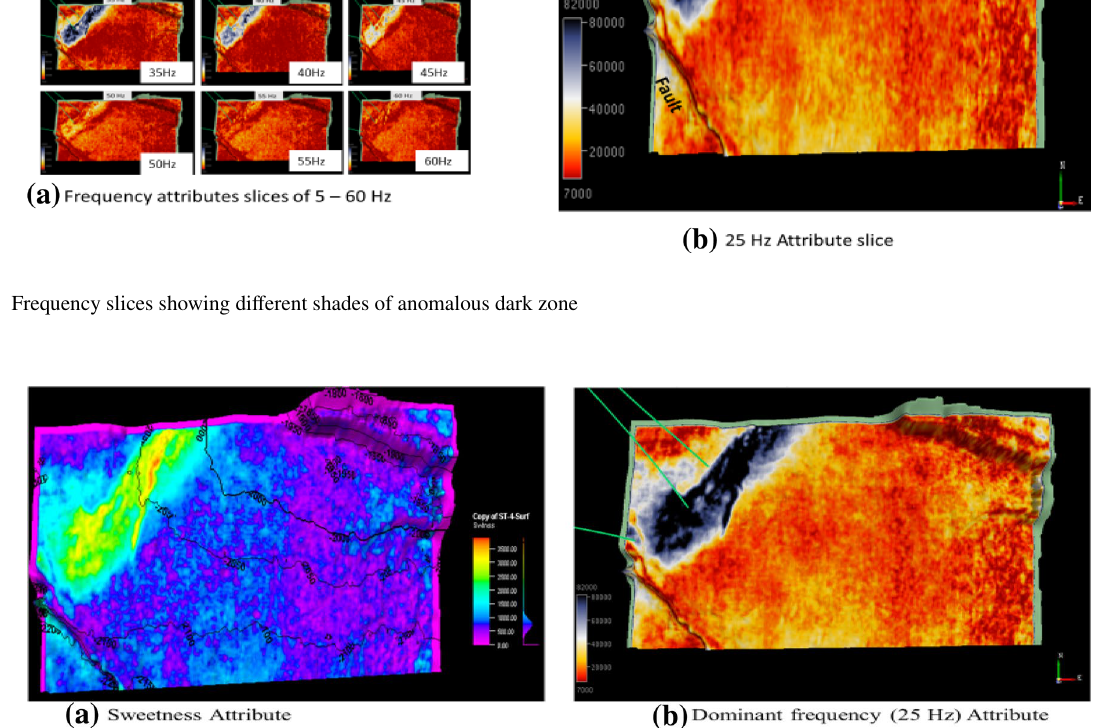
Fig. 12 Comparison of sweetness and spectral frequency (25 Hz) attribute